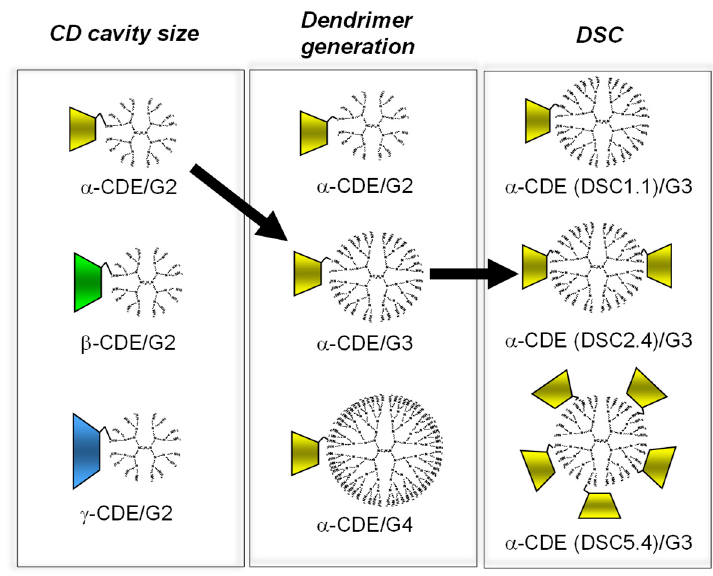
Figure 3. Optimization scheme of α -CDEs as a pDNA